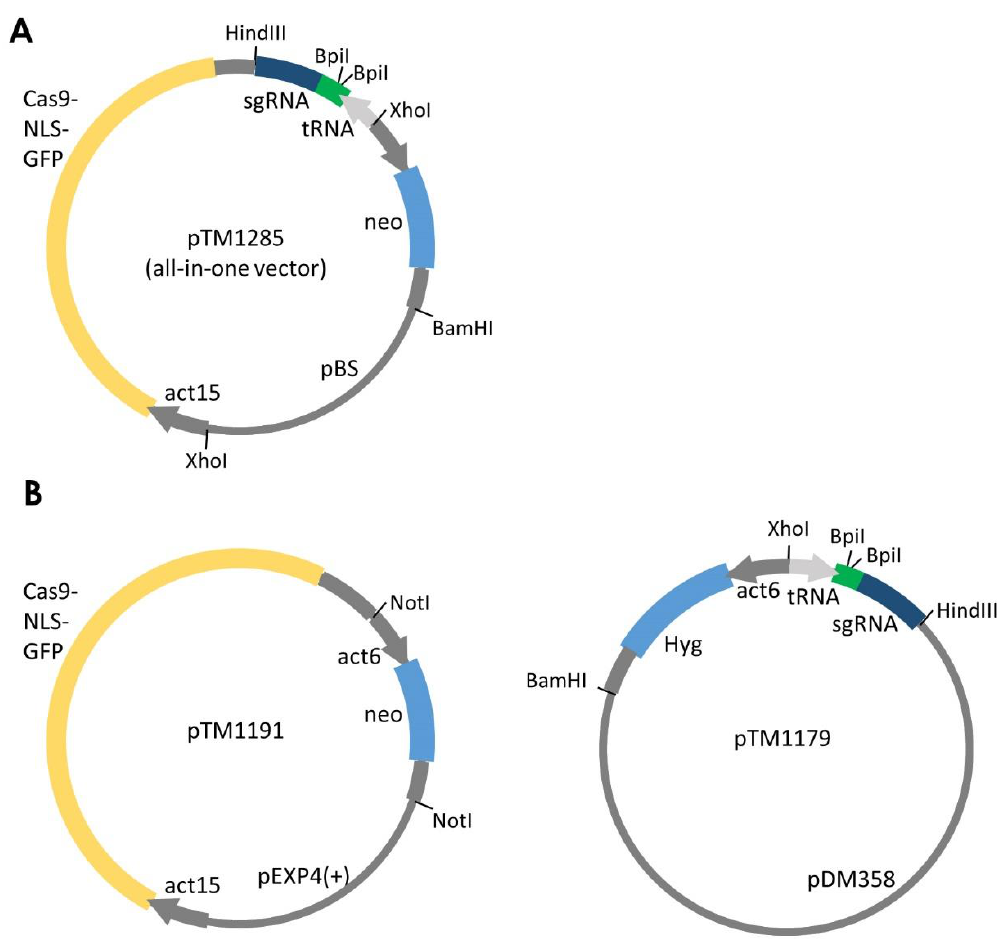
Figure 2. All-in-one and two-plasmid–based systems to express single-guide RNA (sgRNA) and Cas9. ( A ) Schematic of the all-in-one system expressing Cas9 nuclease and sgRNA. ( B ) Two-plasmid–based system for expressing Cas9 and sgRNA from two separate plasmids. The target sequence is cloned into these plasmids using BpiI sites. Both pTM1285 and pTM1179 can be used to express multiplex sgRNAs by inserting multiple tRNA-sgRNA modules. act15, act15 promoter; act6, act6 promoter; tRNA, isoleucine tRNA, neo, neomycin resistance gene; Hyg, hygromycin resistance gene.